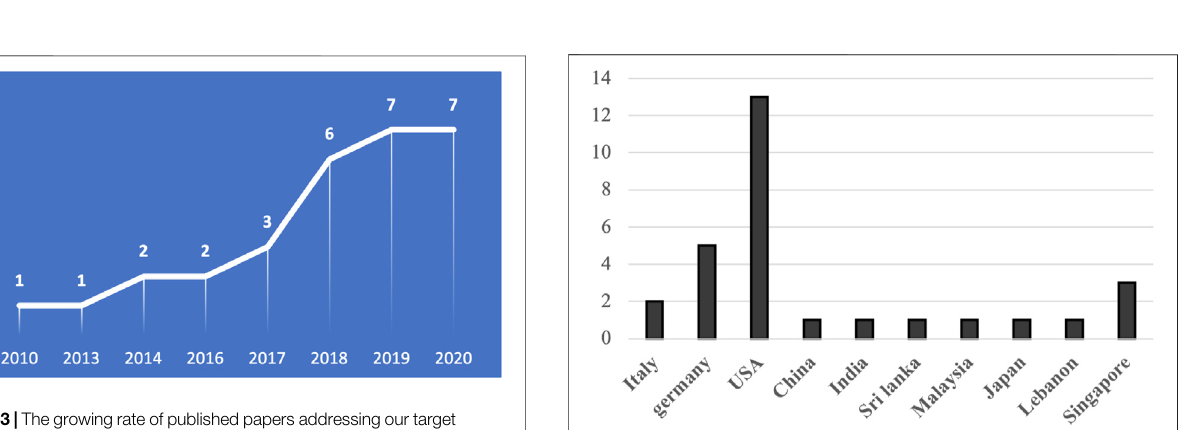
FIGURE 4 | The distribution of reviewed papers over their countries of